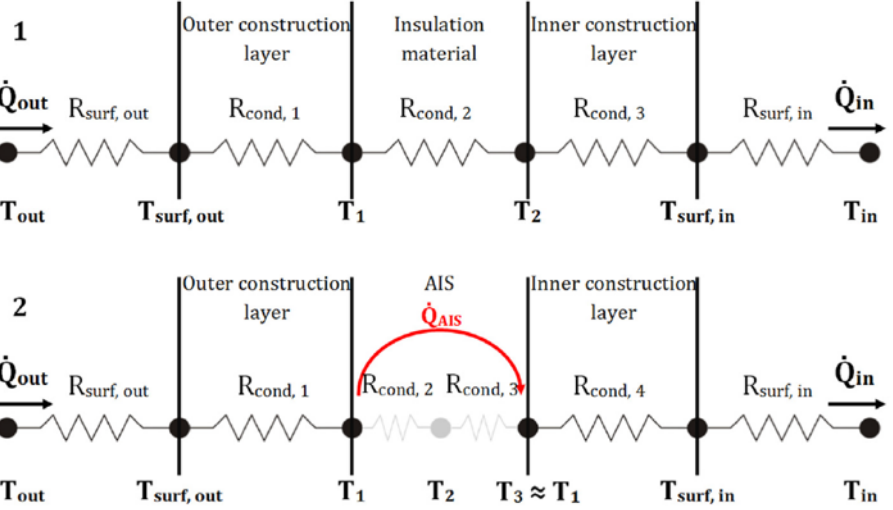
Figure 37. Thermal resistance diagram of ( 1 ) a typical wall and ( 2 ) a wall equipped with a dynamic insulation system [8]. R cond,x —thermal resistance of AIS ((m 2 ·K)/W), R surf —thermal resistance of surface ((m 2 ·K)/W), T x —temperature at point x (°C), Q x —radiant fl ux density (W/m 2 ), and AIS—active insulation system.